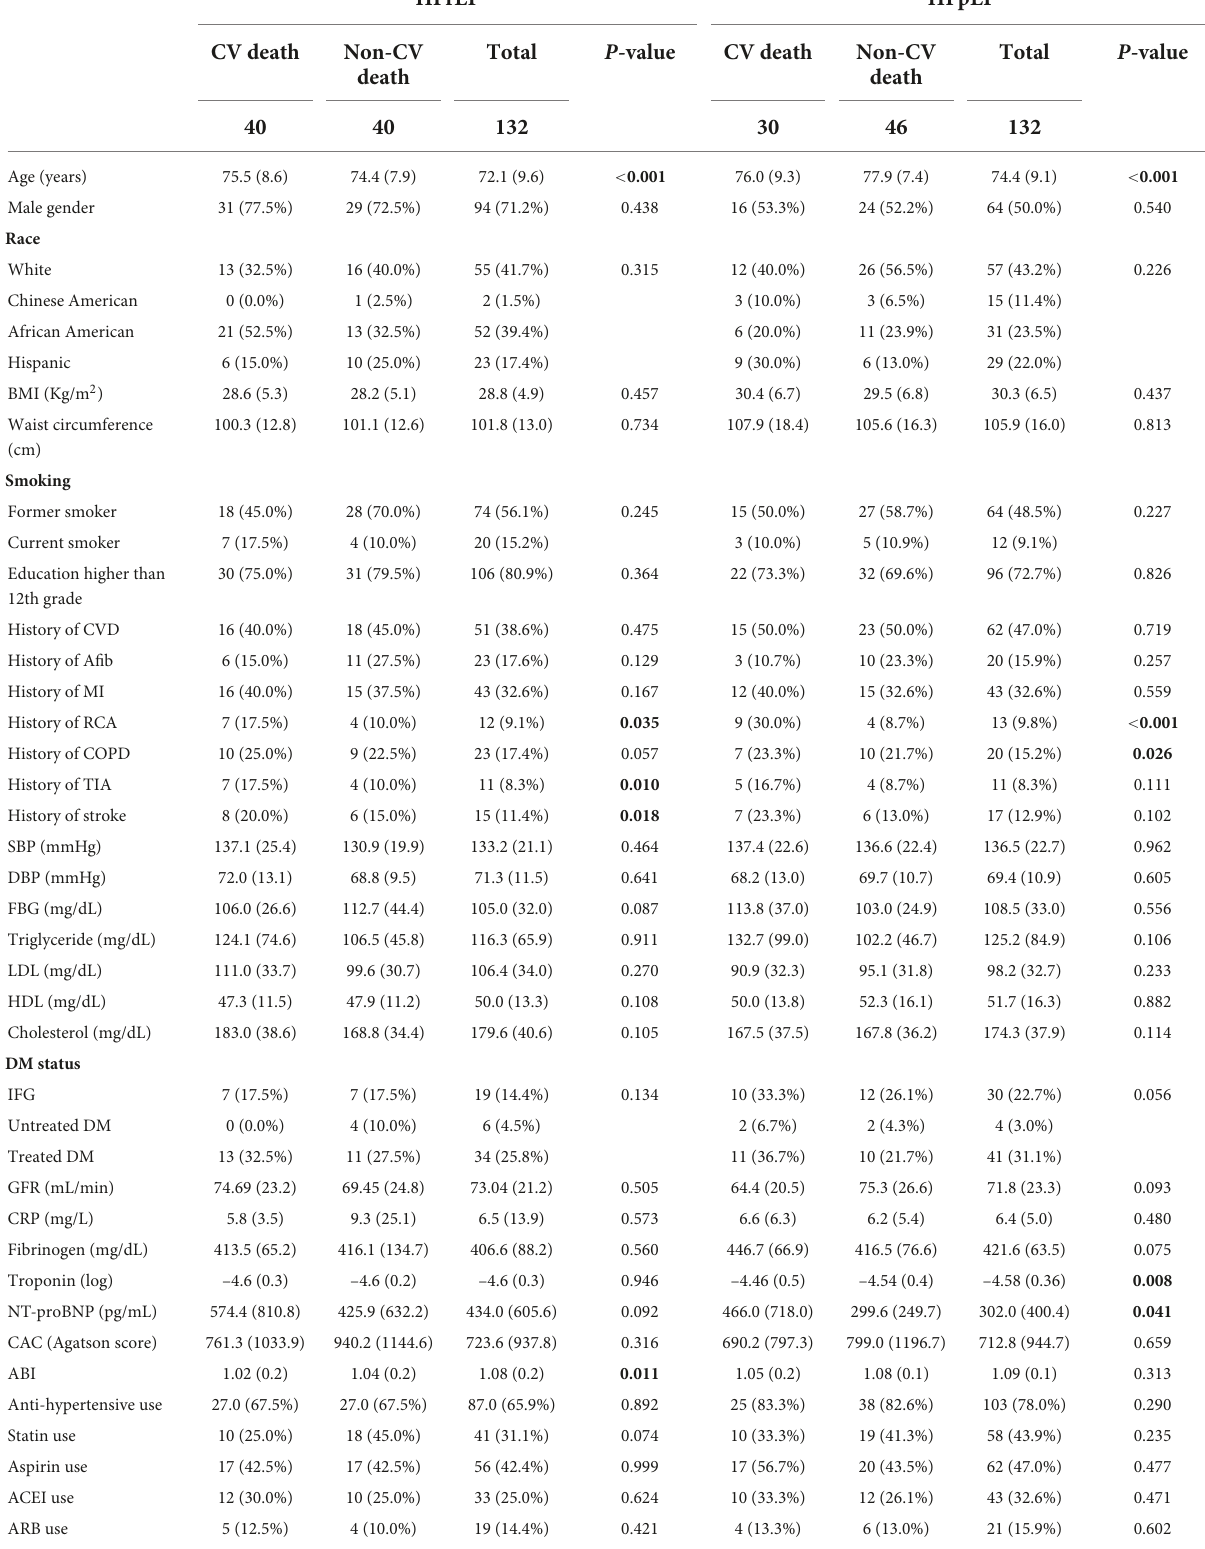
TABLE 1 Distribution of variables prior to HF diagnosis in participants with CV vs. non-CV death and total population, stratified by HF subcategories (HF with reduced ejection fraction [HFrEF] vs. HF with preserved ejection fraction